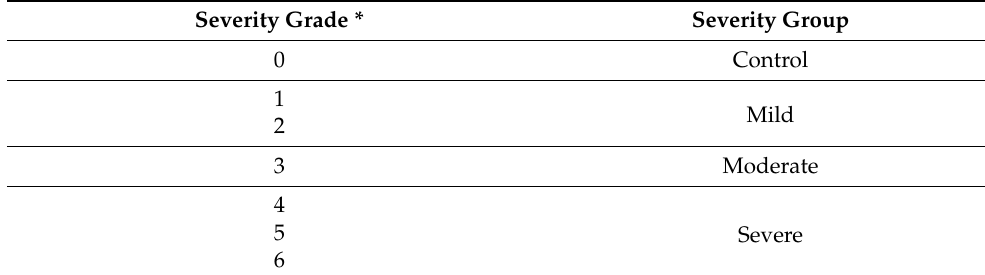
Table 1. Reclassification of severity grade by electrodiagnostic